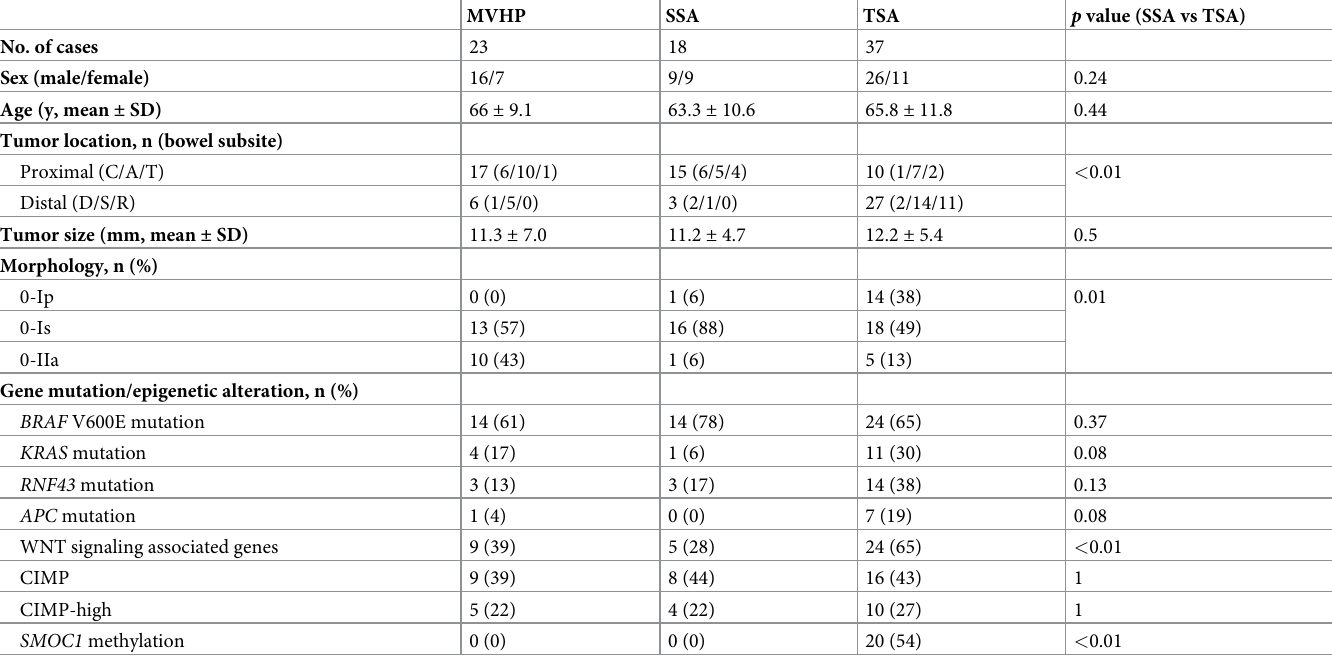
Table 2. Clinicopathological and molecular characteristics of the respective serrated